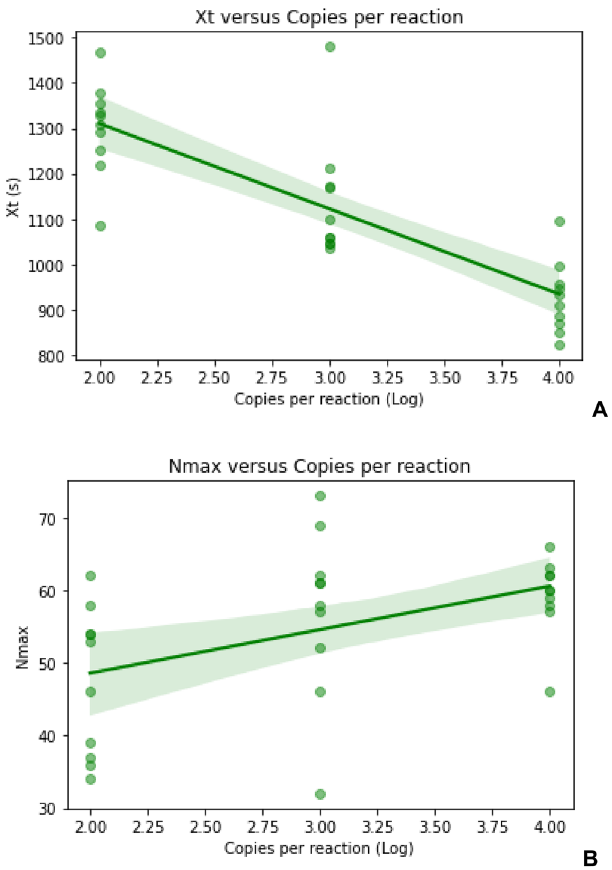
Figure 6. Limit of detection of the test using a control solution containing plasmids pUC57 cloned with the synthetic DNA sequences corresponding either to the sites of gene N or Orf1ab. ( A ) In the x-axis is the dilution of the control solution in copies per reaction in Log and the y-axis is the Xt (initial time of amplification in seconds) of the reactions. ( B ) In the x-axis is the dilution of the control solution in copies per reaction and the y-axis is the Nmax of the